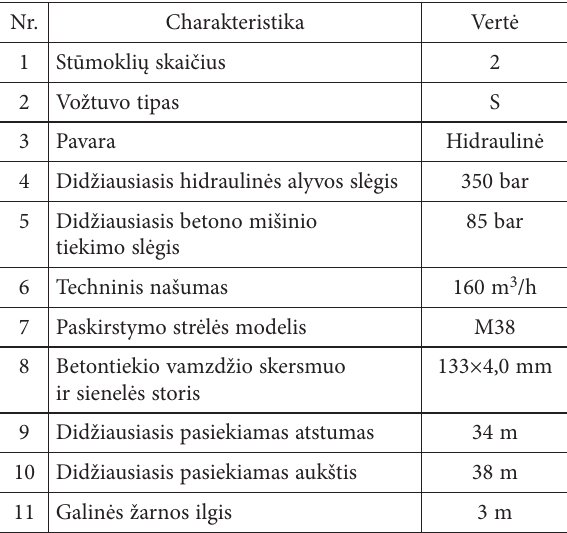
Table 3. The technical information of concrete mixture pump BSF 38-4.16H with distribution arm